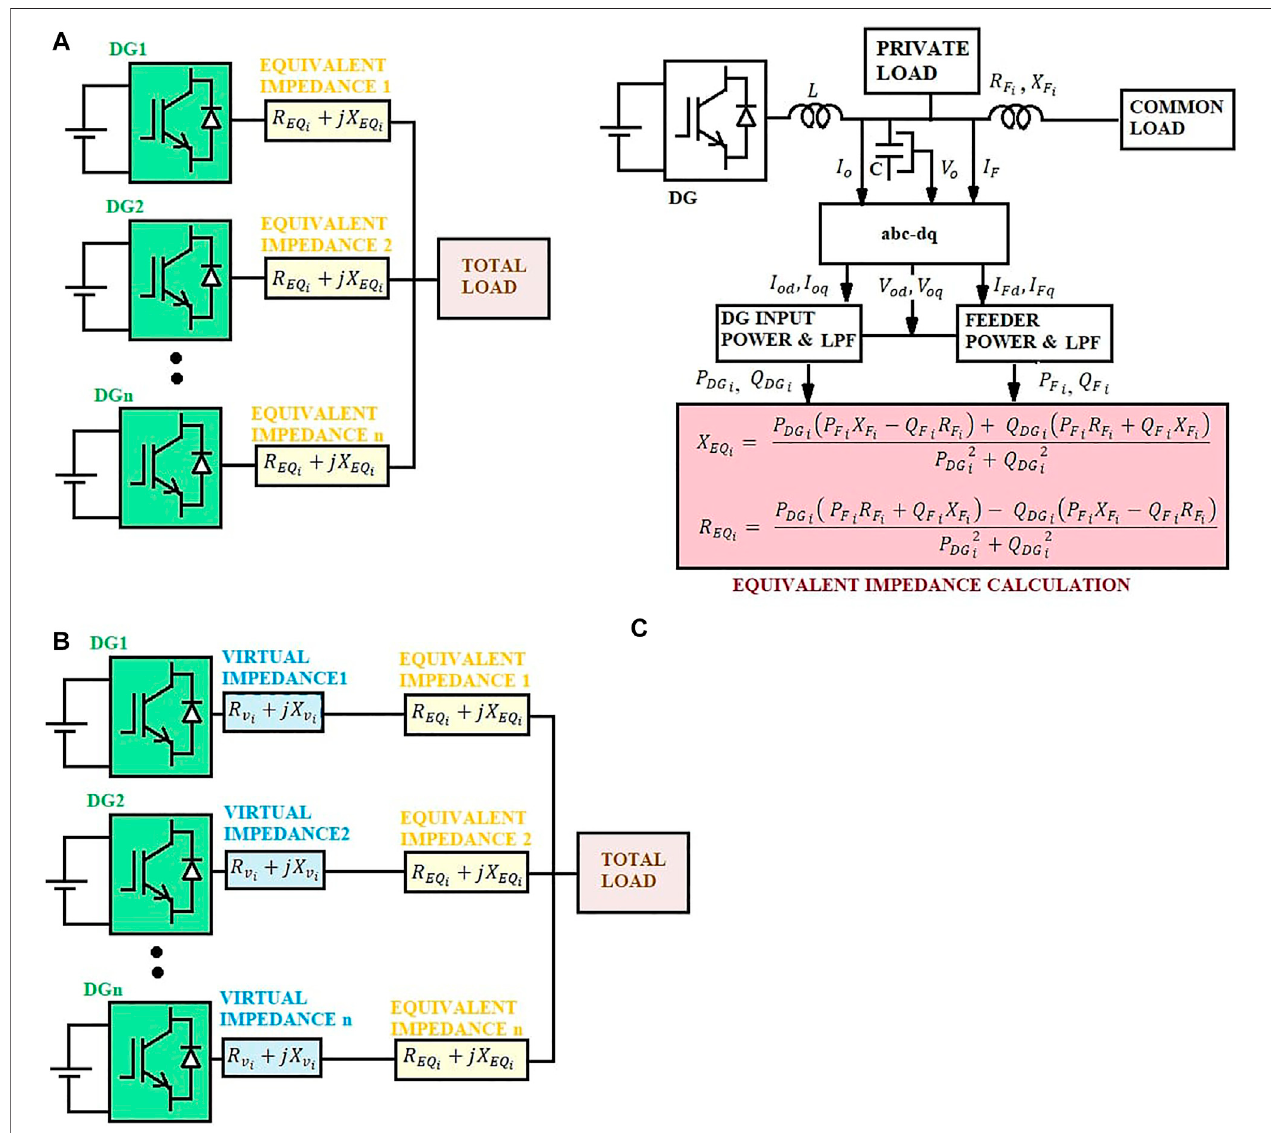
FIGURE2|(A) equivalentoftheMGwithcombinedloadsandequivalentimpedance; (B) blockdiagramforequivalentimpedancecomputation;and (C) equivalent of the MG with series virtual impedance.